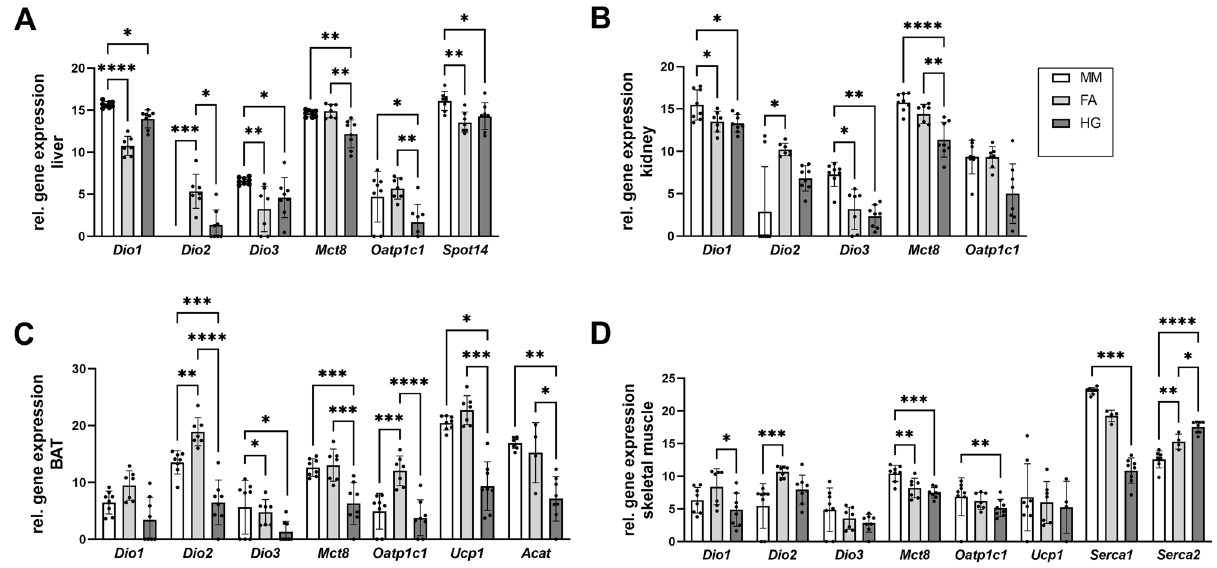
Figure 5. Comparison of gene expression levels in liver, kidney, BAT and skeletal muscle in mice, Ansell’s mole-rats, and naked mole-rats. Gene expression levels in ( A ) liver and ( B ) kidney, representing tissues involved in energy metabolism, and ( C ) BAT and ( D ) skeletal muscle, representing tissues involved in thermoregulation. Target gene expression levels are expressed as arbitrary units based on Ct levels normalised to 100 pg cDNA (see Eq. 2 and Electronic supplementary material) for comparison across species. Normal distributed data were compared with one-way ANOVA followed by Tukey correction. Not normally distributed data were analysed with Kruskal–Wallis test followed by Dunn’s multiple comparisons test when normal distribution was not achieved by log-transformation. Statistical significance was set at the level of p < 0.05 (*), p < 0.01